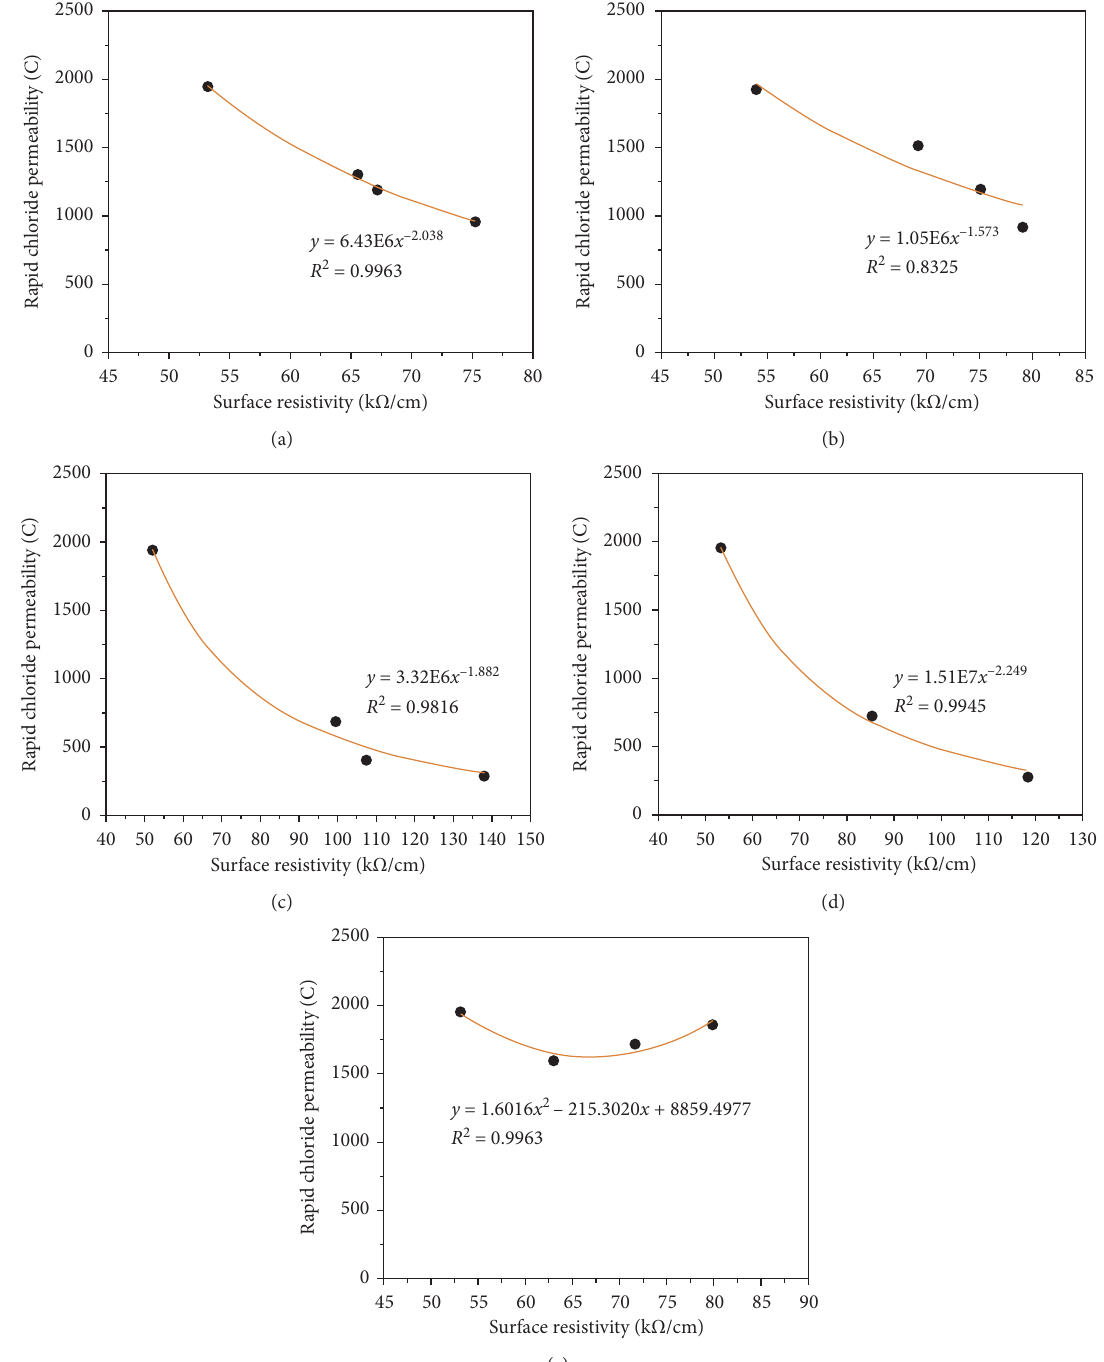
Figure 11: Correlation analysis between surface resistivity and rapid chloride permeability. (a) FA. (b) BFS. (c) SF. (d) Multimineral admixtures. (e) Air